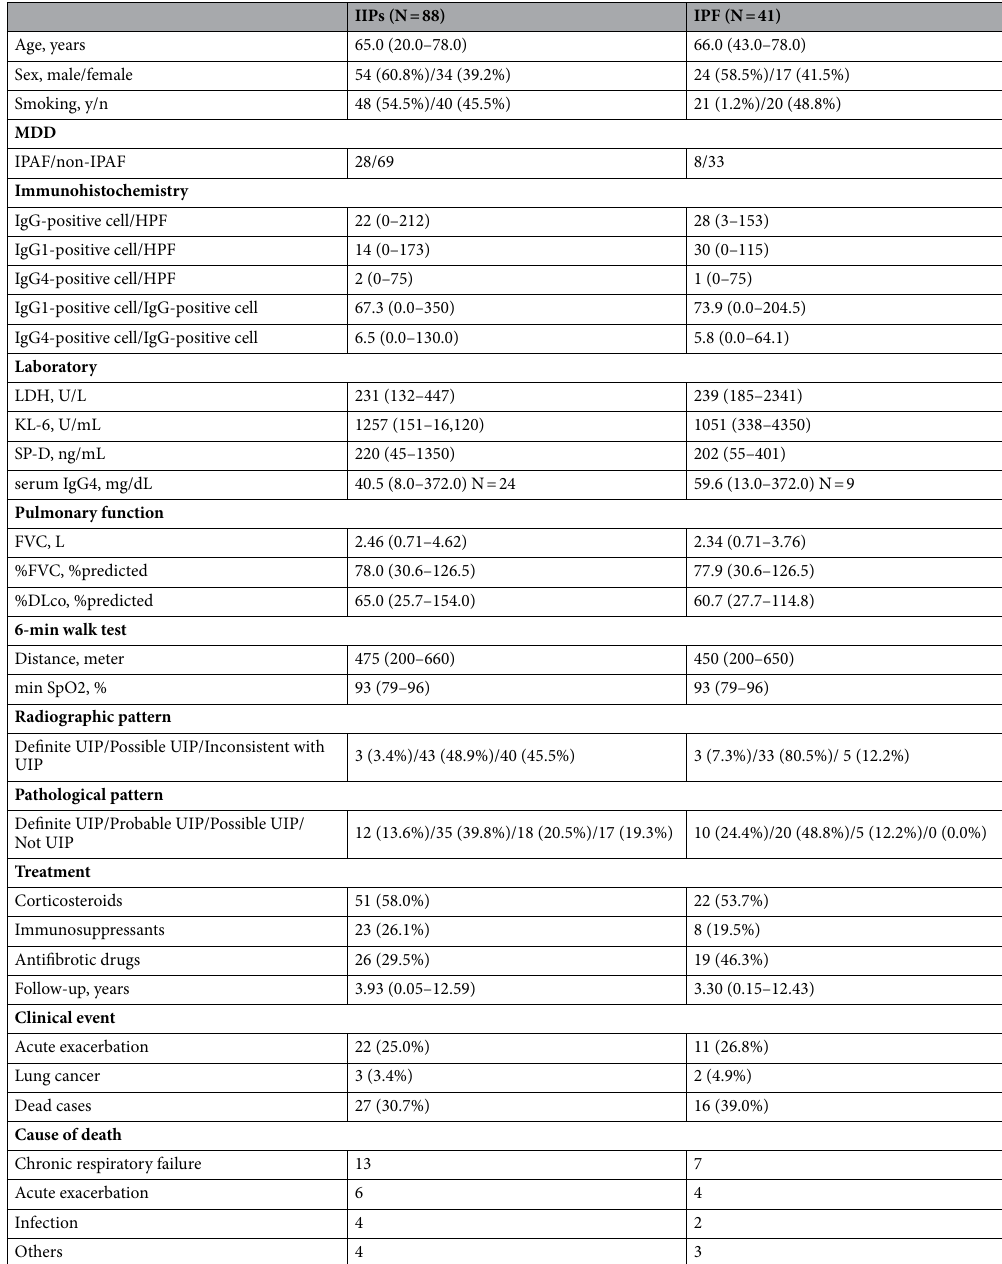
Table 2. Characteristics of patients with IIPs and IPF. Data are presented as the median (range) or N (%). DLco diffusing capacity of the lung for carbon monoxide, FVC forced vital capacity, HPF high-power field, Ig immunoglobulin, IIP idiopathic interstitial pneumonia, IPAF interstitial pneumonia with autoimmune features, IPF idiopathic pulmonary fibrosis, KL-6 Krebs von Lungen-6, LDH lactate dehydrogenase, MDD multidisciplinary discussion, SP surfactant protein, UIP usual interstitial pneumonia, y/n